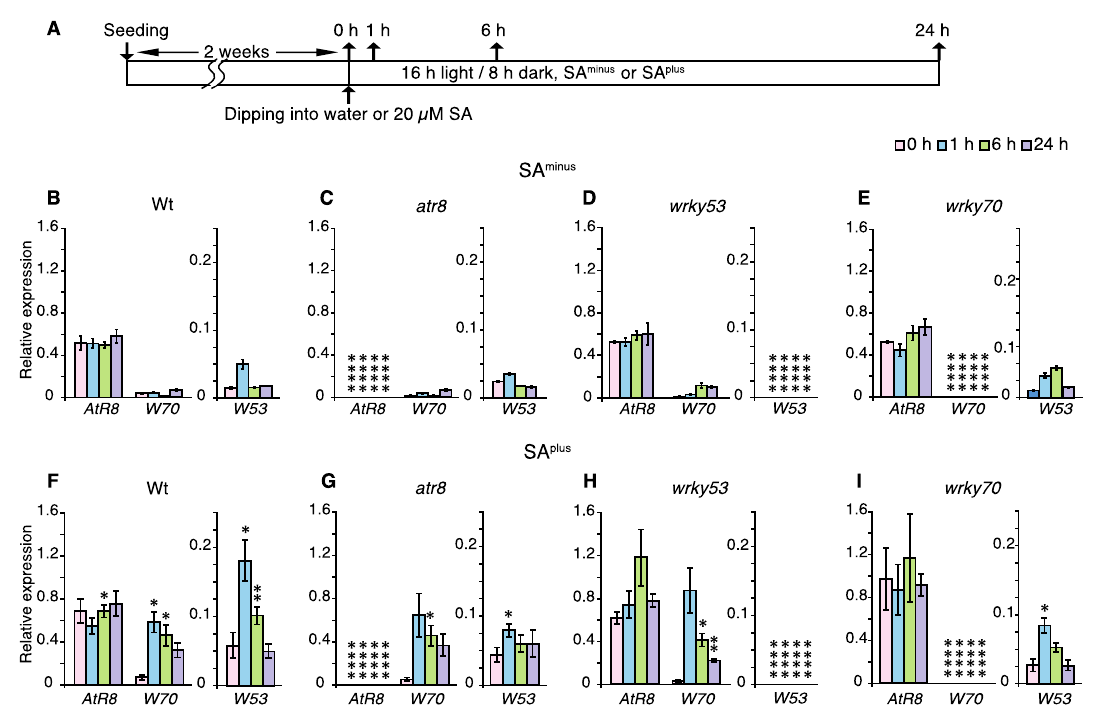
Figure 5. Short-term time course of RNA accumulation immediately after treatment with SA. ( A ) Timeline of experimental procedure with (SA plus ) or without (SA minus ) 20 µM salicylic acid. Two-week-old seedlings were dipped once into the water or 20 µM SA and incubated on fresh media (SA minus or SA plus ). Up arrows indicate samplings. Accumulations of AtR8 lncRNA as well as WRKY53 and WRKY70 mRNA in Arabidopsis plants were measured by RT-qPCR with ACT2 and ACT8 genes as standards. ( B – E ) Controls that were treated with just water (SA minus ). ( F – I ) Seedlings treated with 20 µM SA (SA plus ). Bar graphs represent mean values of three independent assays (≥ 50 plants), and error bars represent ±SE. W53 : WRKY53 , W70 : WRKY70 . Significant differences in RNA accumulations levels between the same strain SA minus and SA plus (Wt: B and F, atr8 : C and G, wrky53 : D and H, and wrky70 : E and I) are indicated as * p < 0.05, ** p < 0.01 and **** p < 0.0001 (Welch´s t -test).